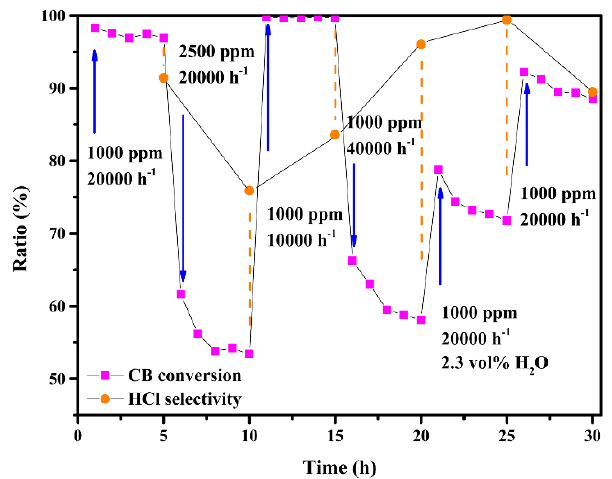
Figure 10. The successive influence of CB concentration, space velocity and water vapor on CB conversion and HCl selectivity over the MCZ-0.67 catalyst at 300 °C.